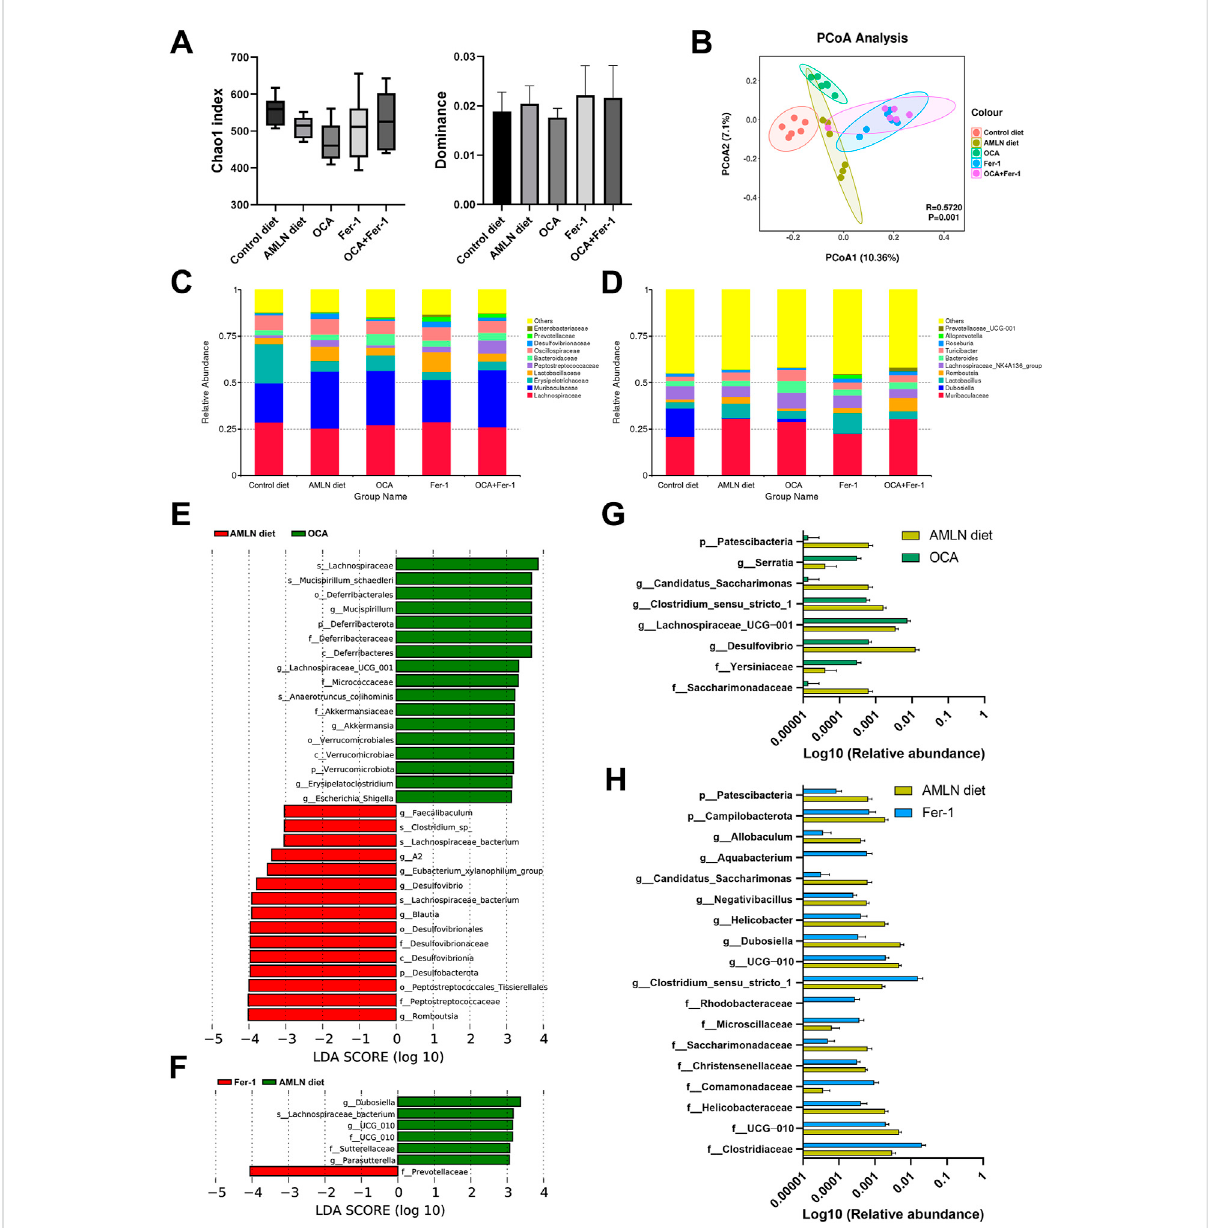
LEfSe cladogram represents thetaxaenriched in thegroups. (G) Taxa with signi fi cant differencesbetweentheAMLN dietgroup with OCA group. (H) Taxa with signi fi cant differences between the AMLN diet group with Fer-1 group. Data are shown as mean ± SEM (D)